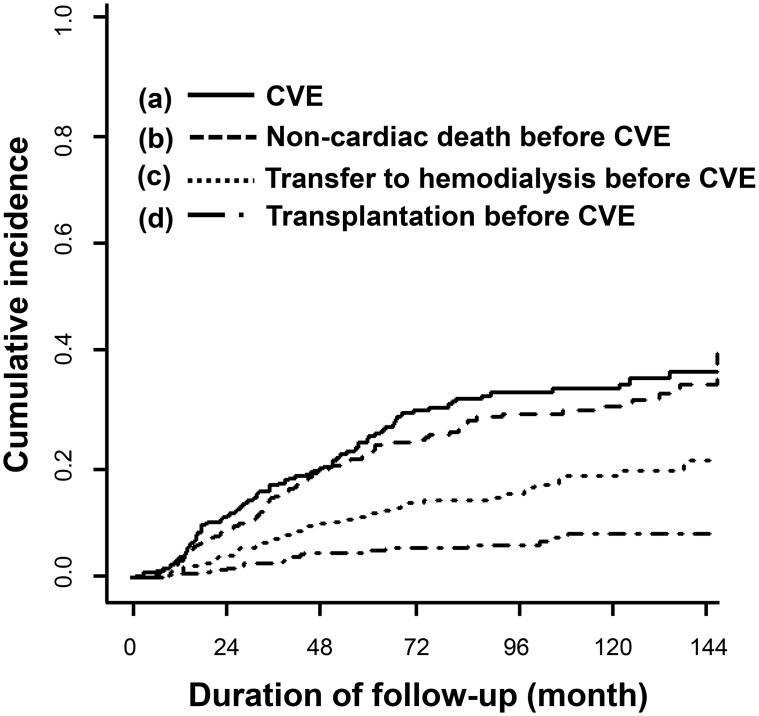
The cumulative incidence curves for a new-onset cardiovascular event and other outcomes.CVE, cardiovascular event.